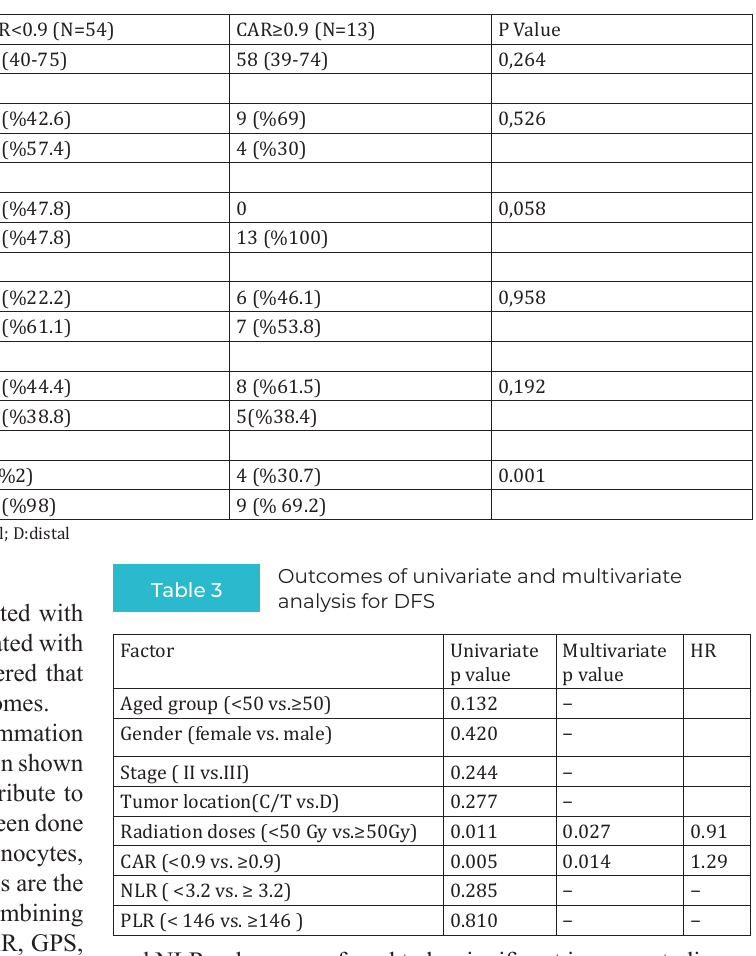
Comparision of CAR value.